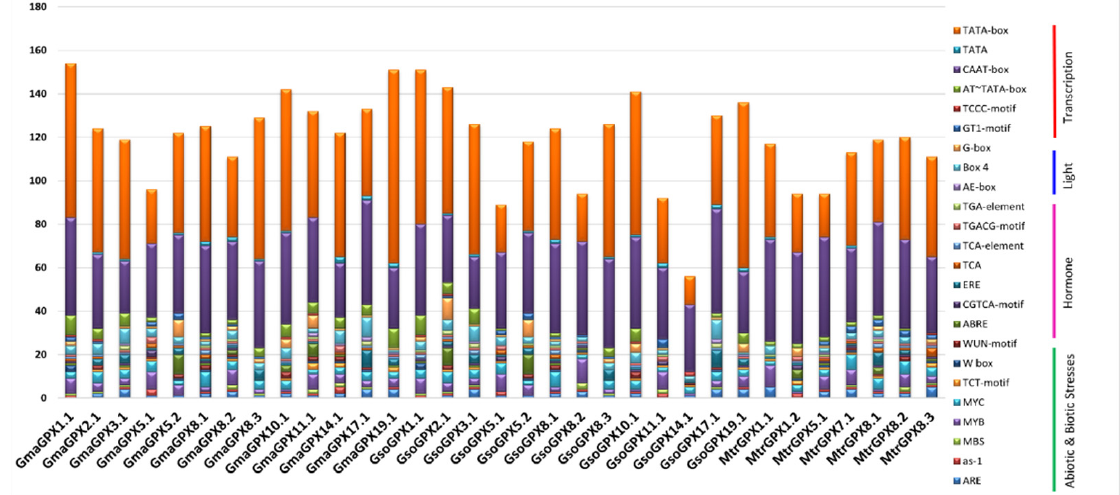
Figure 6. An overview of cis-regulatory elements in GPX family members of G. max and G. soja.